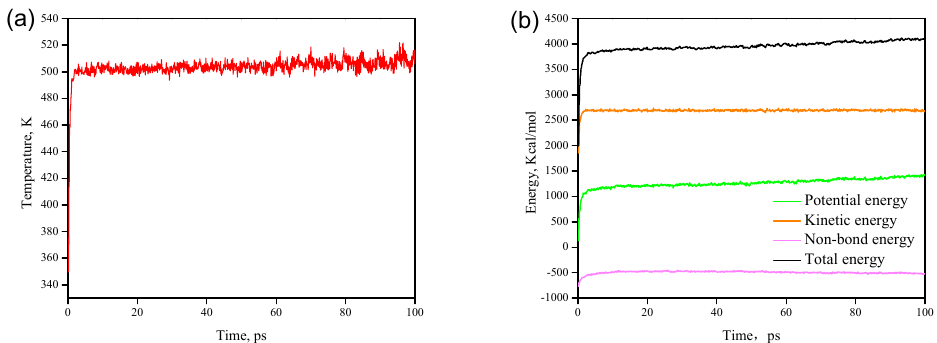
Figure 3. PMMA system relaxation process: ( a ) change curve of temperature; ( b ) change curve of energy.